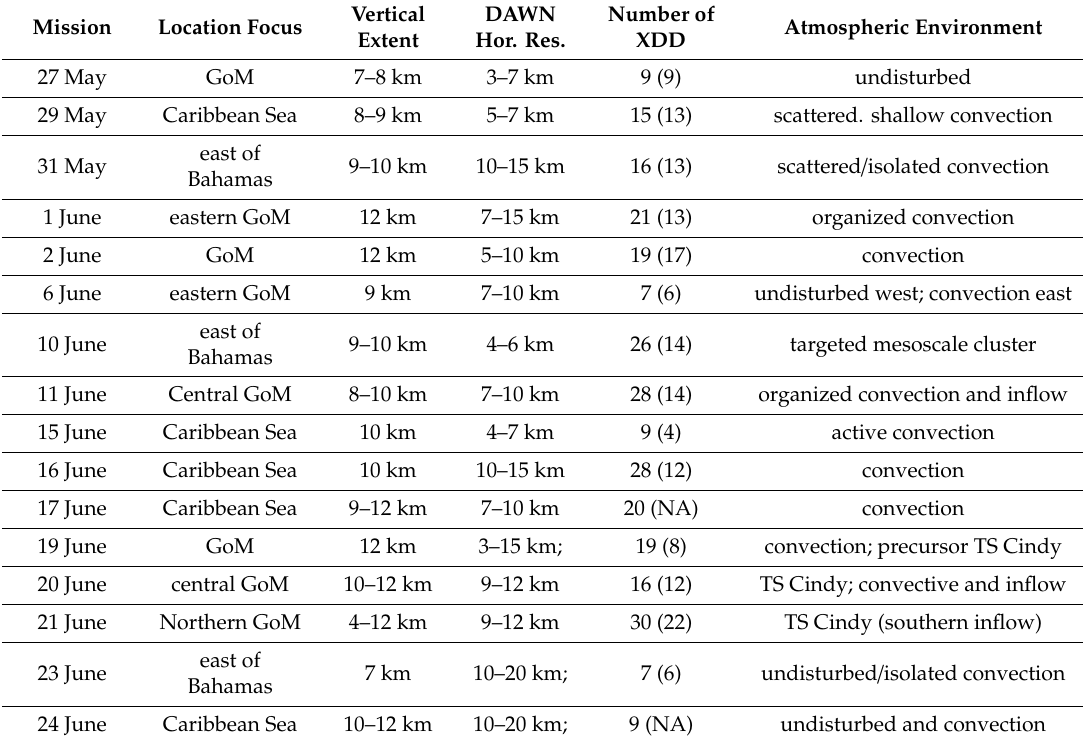
Table 1. Summary of the CPEX flight missions for DAWN and other instruments. Number of XDD dropsondes used in comparisons is noted in